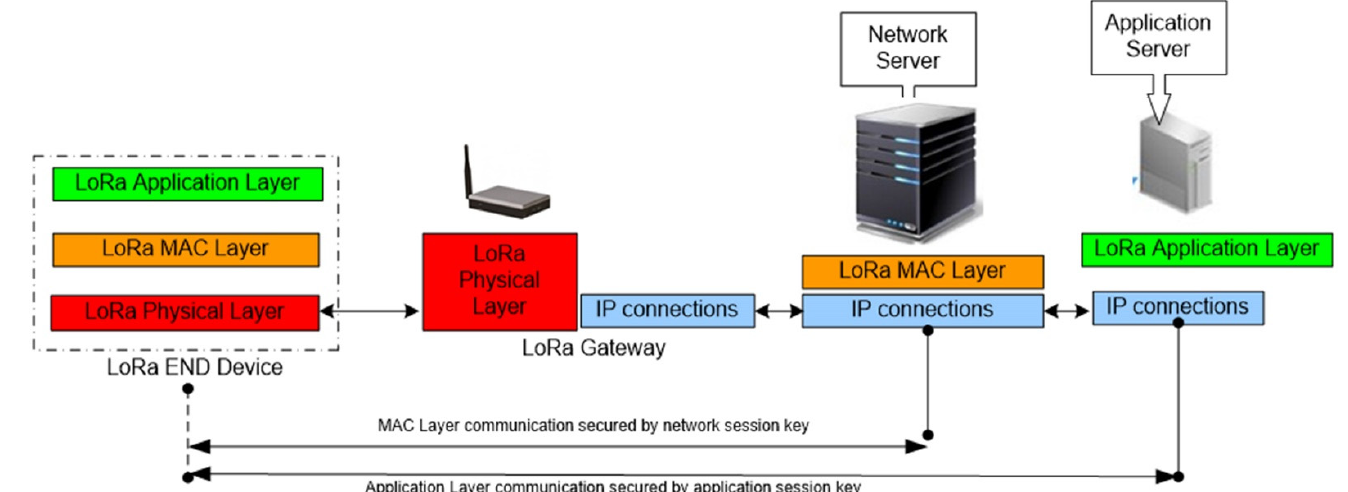
Figure 1. LoRa Physical, Application, and MAC layers of protocol architecture.